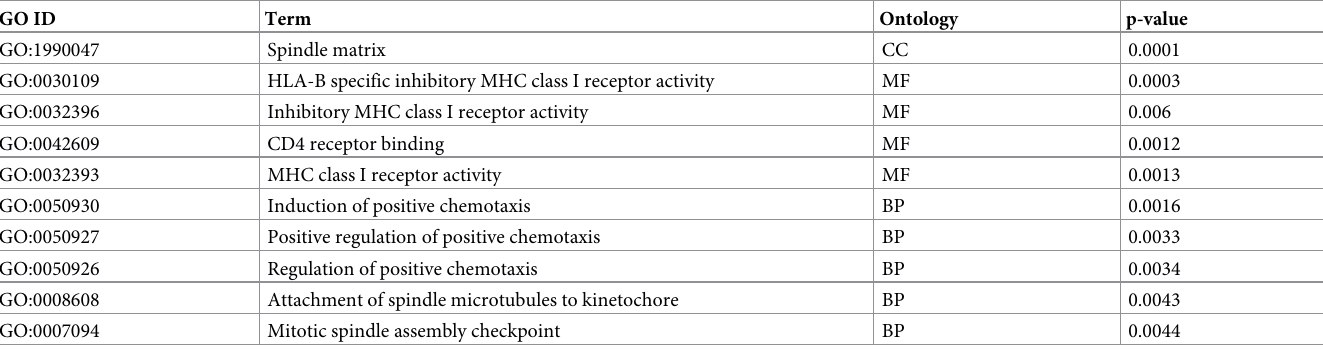
Table 6. GO analysis of stage-salient genes in the order of decreasing significance (i.e, increasing p–value). GO